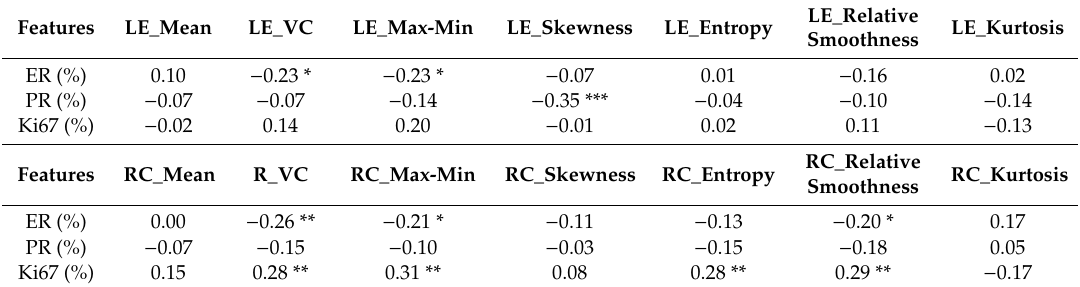
Table 2. Correlation between radiomic features and estrogen receptor (ER), progesterone receptor (PR) and Ki67.